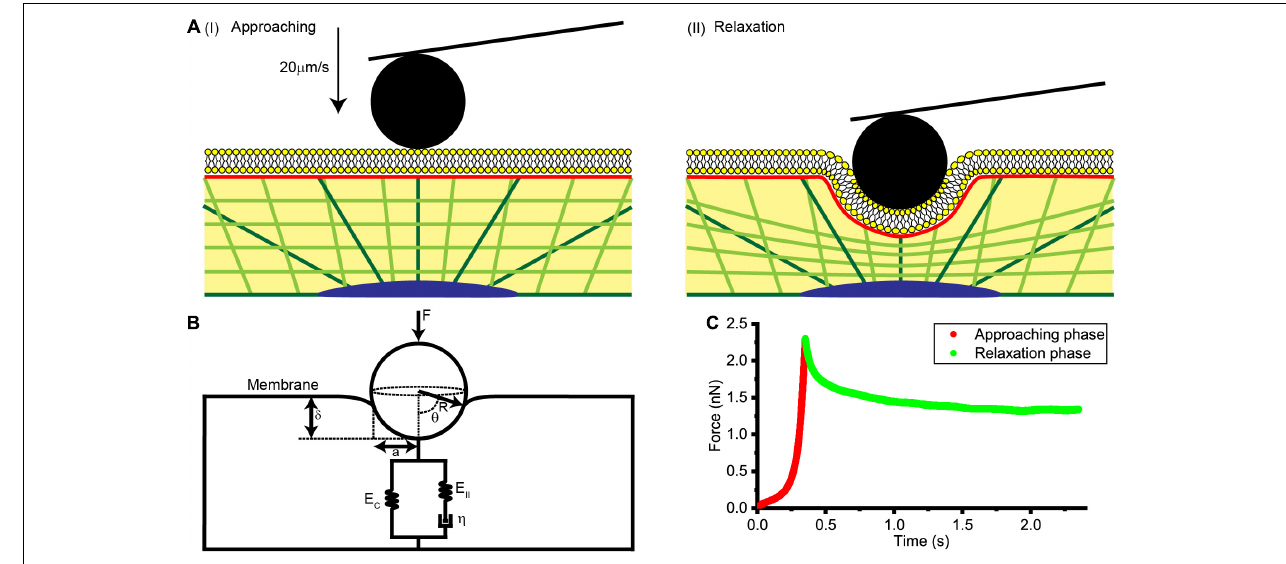
FIGURE 1 | Collection and analysis of AFM force relaxation curves. (A) Schematic diagrams of the process used to acquire the AFM force relaxation curves. (I) Diagram showing the AFM probe approaching the cell at a speed of 20 µ m/s. (II) Diagram showing the AFM probe making an indentation of about 1 µ m in the cell and then kept still at this location. (B) A physical model of the cell membrane, cytoskeleton, and cytosol considered together for a spherical probe. F is the loading force of AFM indenter, R is the radius of spherical probe, θ is the integral angle, δ is indentation depth, a is the effective contact radius, E C , E II , and η are the elastic and viscos elements that make up the standard linear solid model of cytoplasm. (C) Force-time curve at the approaching phase and relaxation